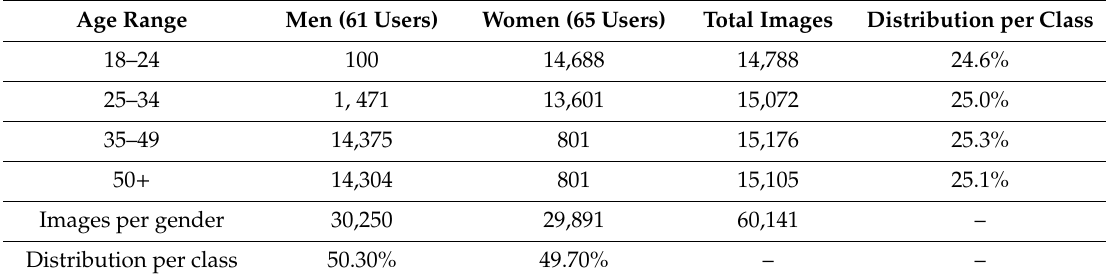
Table 4. Number of images per gender and age range in DB1 dataset.